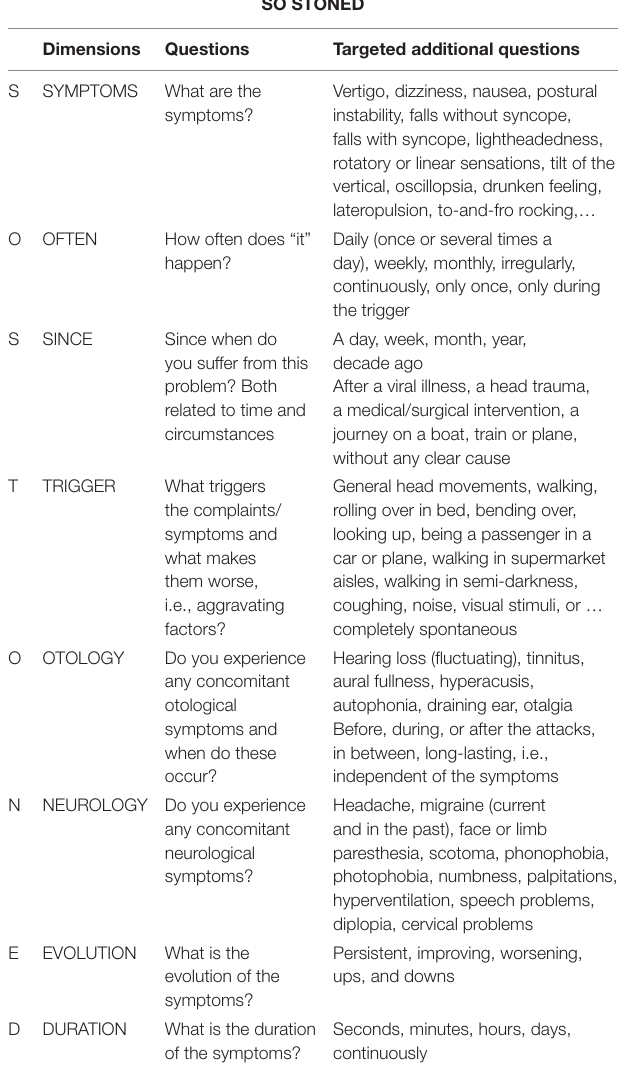
tABLe 1 | Overview of the sO stONeD dimensions and their appropriate questions. sO